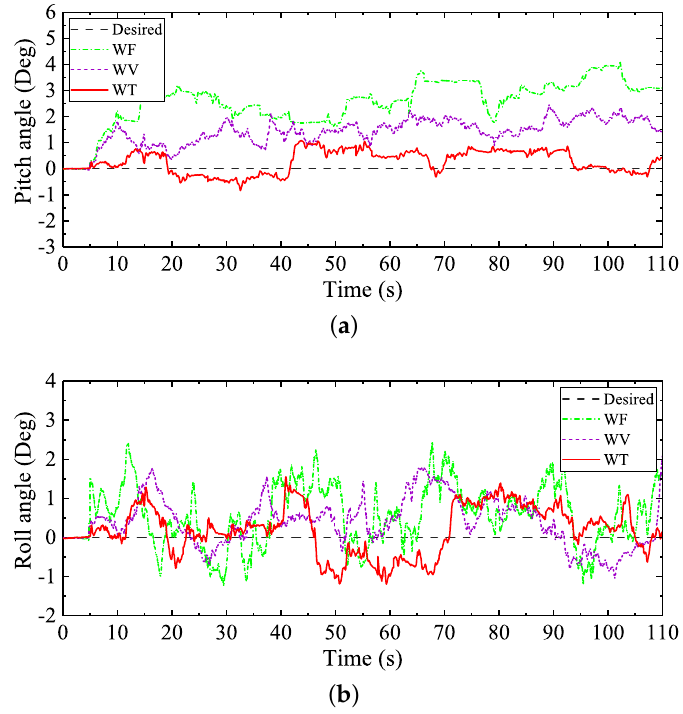
Figure 15. The attitude regulation performances of the pitch and roll angles under different control schemes: ( a ) the body pitch angle comparison and ( b ) the body roll angle